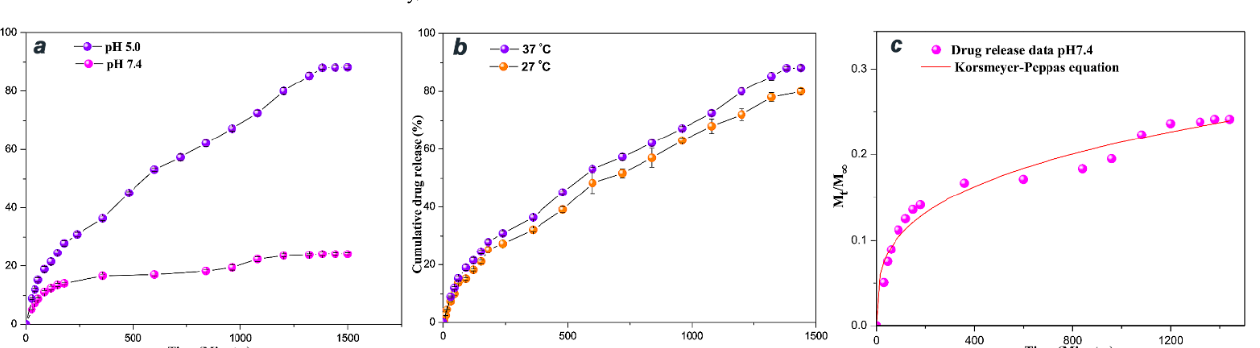
Figure 6. Release profiles of FMSNs, FMSNs@PDA, and FMSNs@PDA@GO when ( a – d ) ibuprofen and ( e – h ) acetaminophen were loaded in PBS (pH 7.4) at 37 °C. Model fits of ibuprofen and acetaminophen release from FMSNs-Drug, FMSNs-Drug@PDA, and FMSNs-Drug@PDA@GO by the Fickian exponential or Higuchi model versus cumulative time or square root time, and Kp model versus cumulative time. Reprinted/adapted from ref. [321] with permission from RSC—Royal Society of Chemistry, 2020.